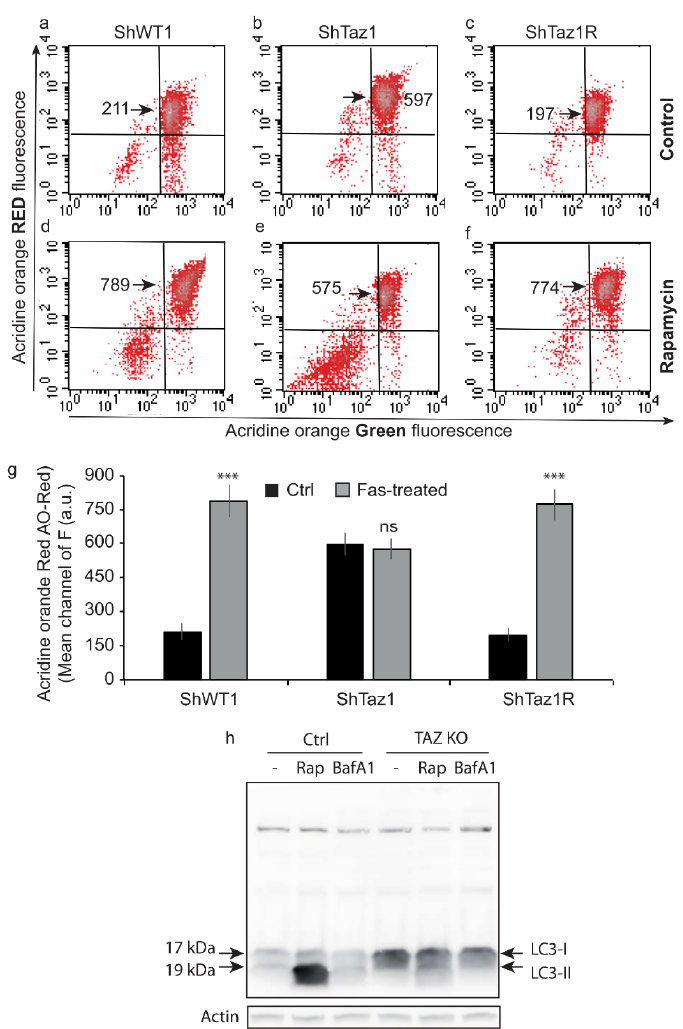
Figure 9. Flow cytometry analysis of acridine orange staining and LC3 Western blot. ( a – f ) Flow cytometric analysis of AO staining for the three cell lines (ShWT1, ShTaz1, and ShTaz1R) as described in materials and methods when treated or not with rapamycin for 24 h. Green fluorescence when the AO molecules are free or bind to the DNA; red fluorescence in an acidic environment where the molecules form stacks (Stokes shift). The histograms of green and red fluorescence show the enhancement of the acidic compartment (red fluorescence), but also the death of cells, which usually lose their acidic vesicles and have a compacted DNA resulting in less green fluorescence (green fluorescence). ( a – c ) Basal acidic vesicles/untreated cells ( d – f ) Cells treated with rapamycin (autophagy inducer) for 24 h. ( g ) Histogram representation of red fluorescence (mean values) in monitoring of acidic vesicle (lysosomes and certainly autophagosomes) statistics are given for 12 different preparations. ( h ) Western blot analysis of LC3 staining following basal, or rapamycin, or bafilomycin A3 treatment of the three cell lines (ShWT1, ShTaz1 and ShTaz1R). ns = no significant and *** is the p -value ≤ 0.001.